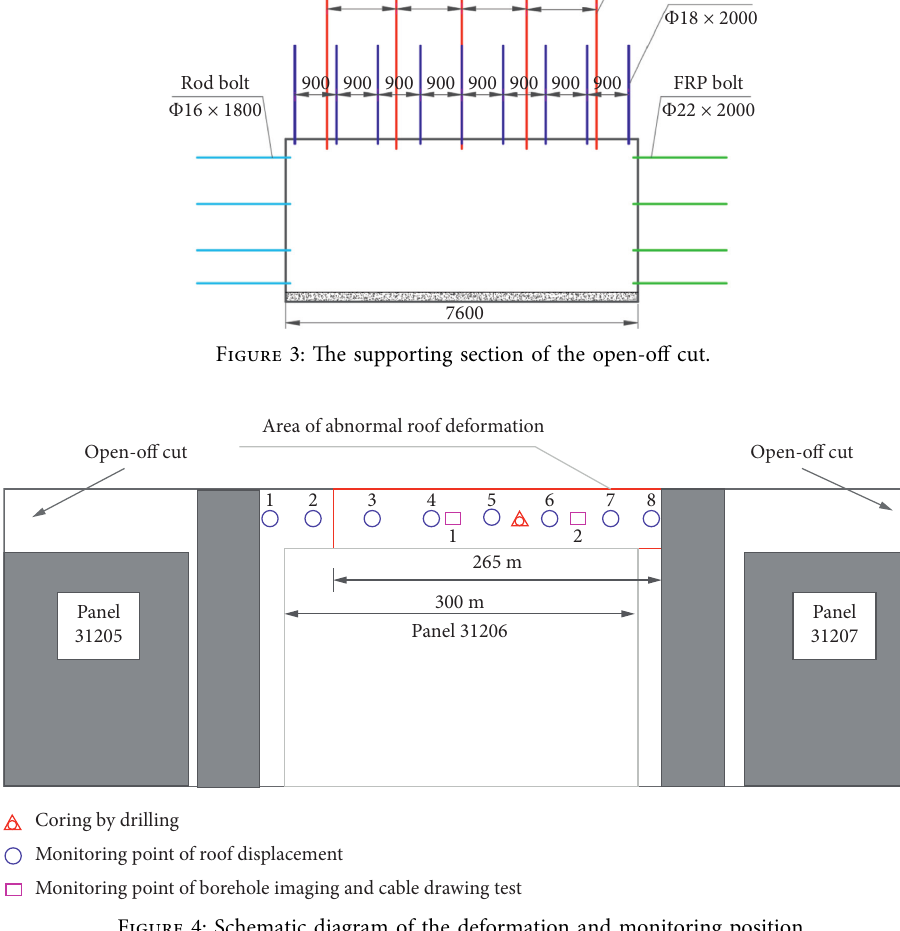
Figure 4: Schematic diagram of the deformation and monitoring position.